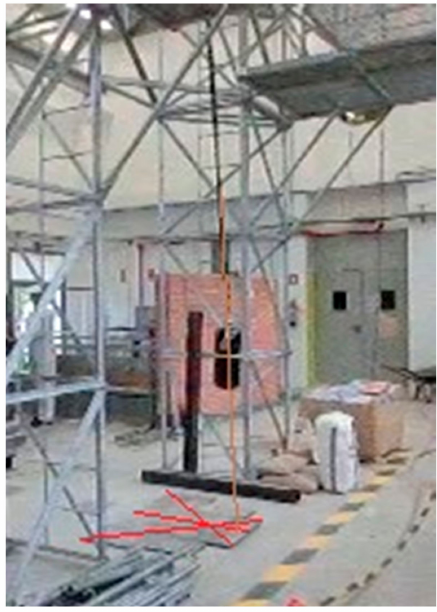
Figure 6. Frame corresponding to the maximum stretch moment for experiment VIII. Some auxiliary lines in the ground help to locate the point to measure the distance from it to the bottom of the